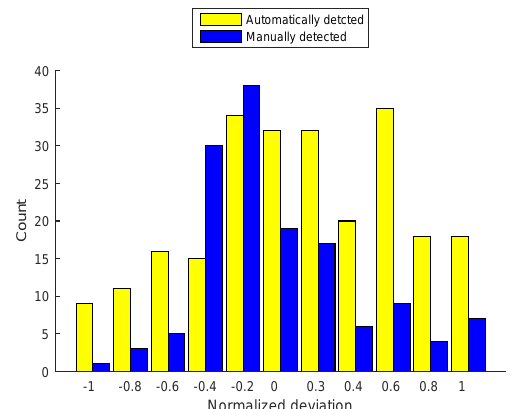
Figure 8: Histogram of normalized deviation automati- callymanually determined mean TLS of 44/49 seconds follow Fayazi et al. (2015).